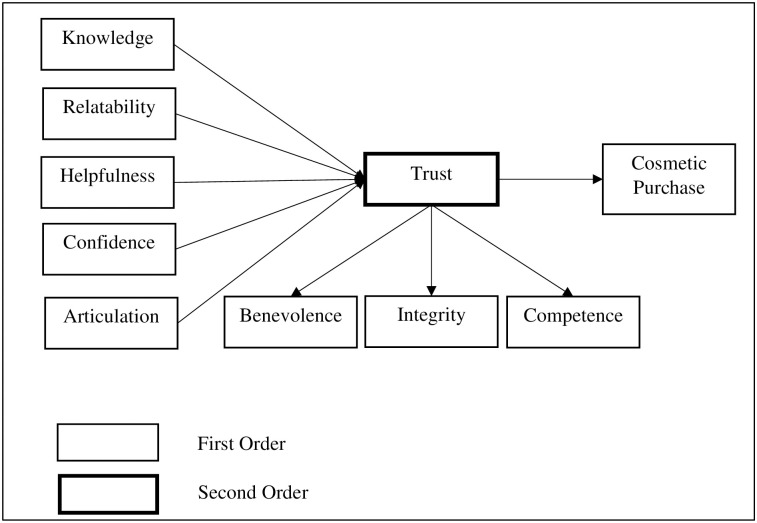
Research framework.